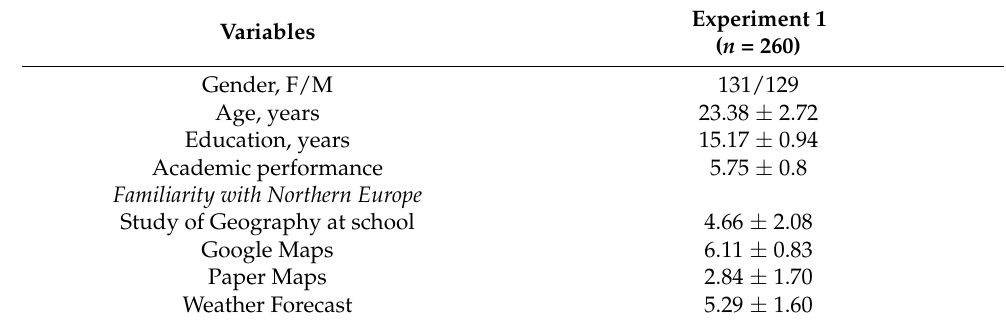
Table 1. Descriptive statistics of the sample. Means ± standard deviations for interval and frequencies for nominal variables were reported. χ 2 for frequencies were performed.